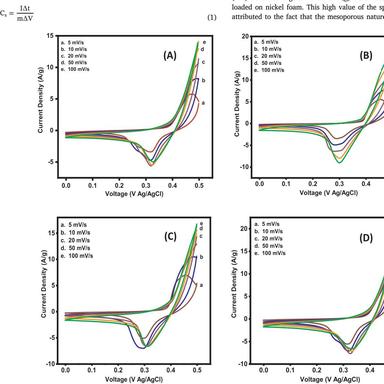
Relationship of specific capacitance with scan rate of Pr6O11, Pr6O11/ Mn3O4-0, Pr6O11/Mn3O4-1 and Pr6O11/Mn3O4-2.